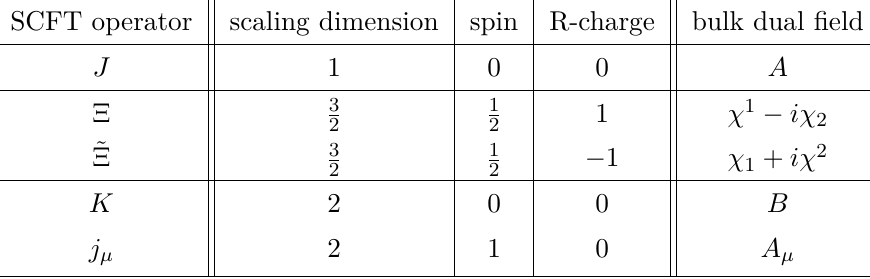
Table 4 . The conformal primaries of an N = 2 flavor current